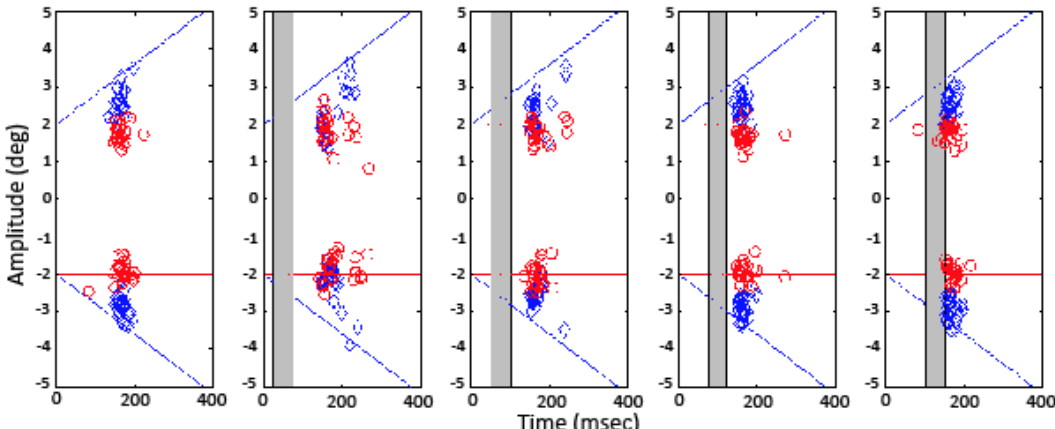
Figure 4 : Saccade endpoint relative to the target position for subject AR for the step only conditions (red) and the step- ramp away conditions